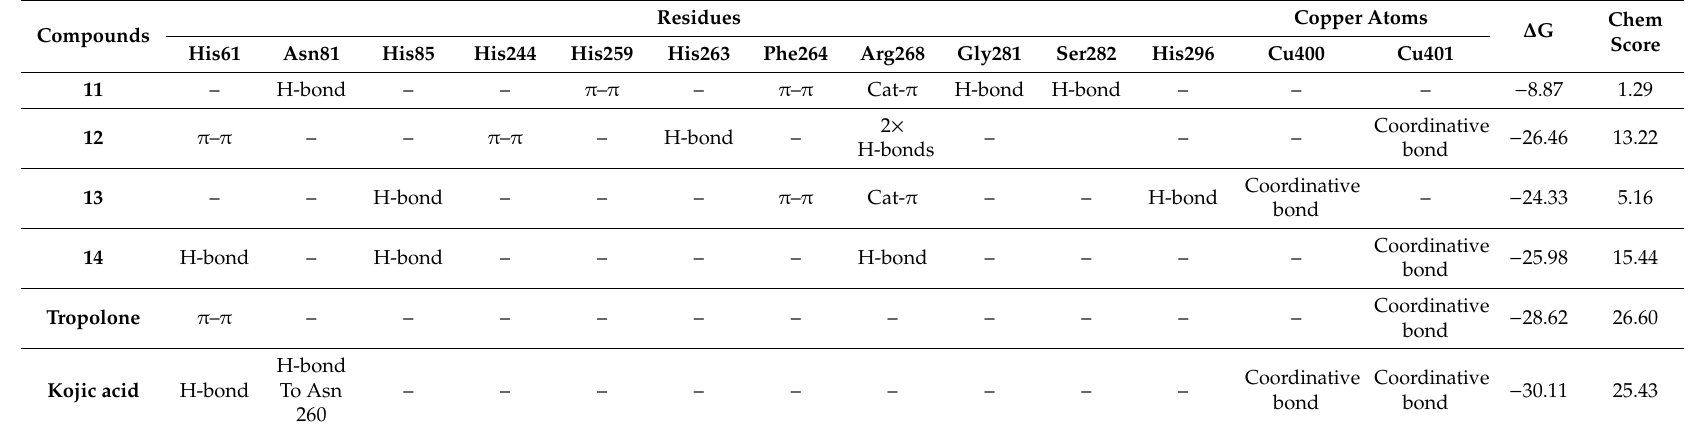
Table 5. Summary of the interactions found in the best pose of Kojic acid, tropolone, and compounds 11 – 14 identified in the sea rocket ( Cakile maritima ) extracts, docked to